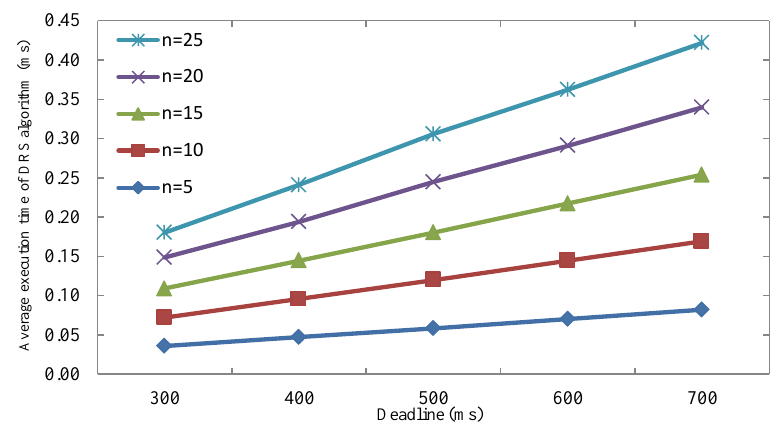
Figure 11 Finishing time reduction for synthesized tasks.